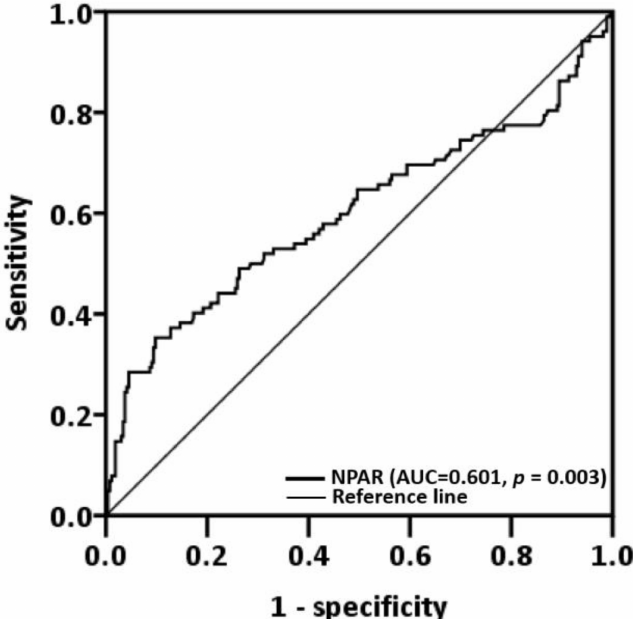
Figure 1. Neutrophil percentage-to-albumin ratio cutoff obtained through receiver operating charac- teristic curve analysis. Abbreviation: AUC, area under the curve.